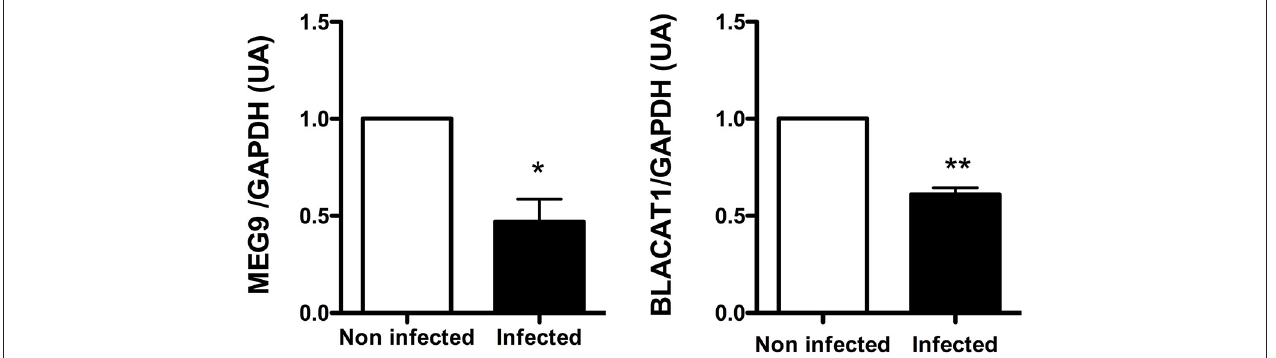
FIGURE 4 | Validation by qRT-PCR of BLACAT1 and MEG9 expressions in bronchial primary epithelial CF cells infected with Pa . RNA were purified in CF cells collected from 4 different patients and infected with Pa . LncRNA levels were measured at 0 (white bar) and 2 h (black bar) post-infection for MEG9 and 0 (white bar) and 6 h (black bar) post-infection for BLACAT1. The statistical analysis consisted in a paired t- test. * P < 0.05 and ** P < 0.001.